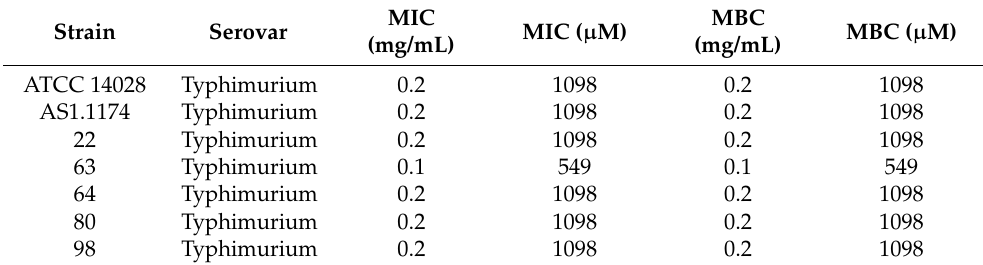
Table 1. The MICs and MBCs of CoQ 0 against S.